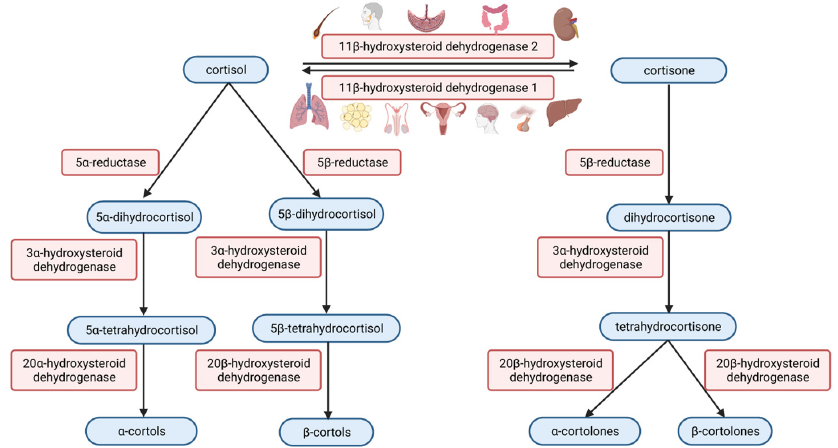
Figure 4. Cortisol metabolism pathway. The principal steps of cortisol metabolism are demonstrated. However, not all enzymes are found in all tissues, e.g., 11-hydroxysteroid dehydrogenase type 2